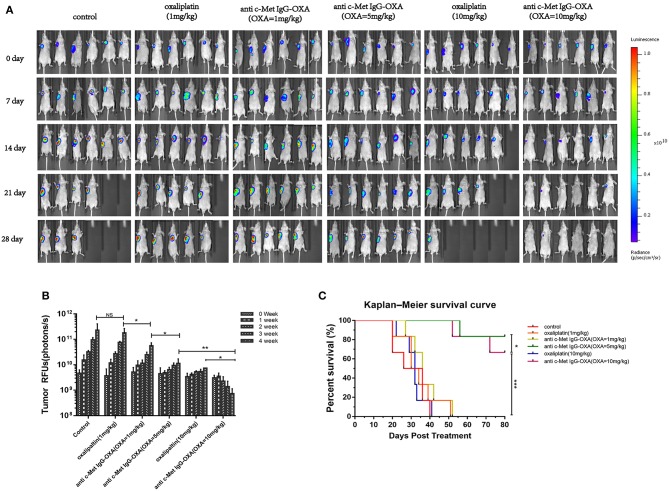
In vivo optical imaging analysis performed using the optical imaging system IVIS200 in mice bearing HepG2-luc cells. (A) Bioluminescence signal measured once a week after treatment with free oxaliplatin or anti-c-Met IgG-OXA in nude mice. The fluorescence image showed the lowest intensity NIRF signal for the tumour site in the conjugates than with the same dose of free oxaliplatin. (B) A quantitative graph of the tumour is depicted for each group with the signal-to-background ratio. (C) Kaplan–Meier survival analysis of nude mice (n = 6 for each condition) following tail-vein injection of free oxaliplatin or anti-c-Met IgG-OXA and monitoring over 80 days. A significant serious burden of adverse drug reactions was observed with the high dose of oxaliplatin (10 mg/kg). The percentage of remaining survival in the high-dose oxaliplatin group (10 mg/kg) (33.33%) was lower than that in the control group (50%) at 28 day, which was far below the group treated with ADC (10 mg/kg) (100%). ADC demonstrated a significant improvement of the survival rate compared with the same dose of oxaliplatin and the control group. *P < 0.05, **P < 0.01, and ***P < 0.001.